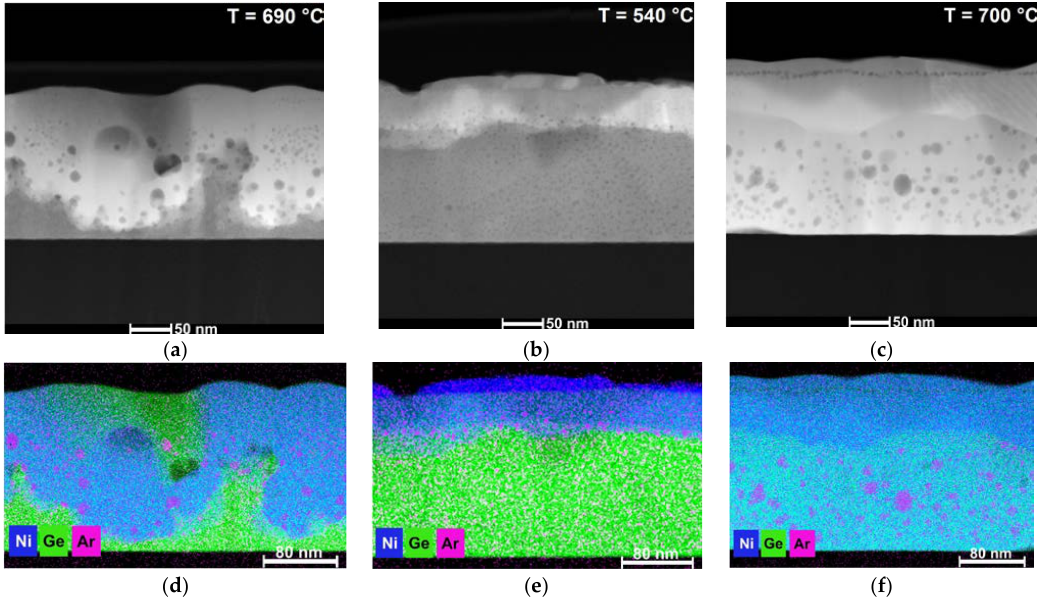
Figure 3. Cross-sectional high-angle annular dark-field scanning transmission electron microscopy (HAADF-STEM) images of annealed bilayers of ( a ) 30 nm Ni on 160 nm a-Ge, ( b ) 30 nm Ni on 160 nm poly-Ge and ( c ) 100 nm Ni on 160 nm poly-Ge at various peak temperatures. The corresponding qualitative element distributions were determined by energy-dispersive x-ray spectroscopy (EDXS) based on spectrum imaging analysis ( d – f ).